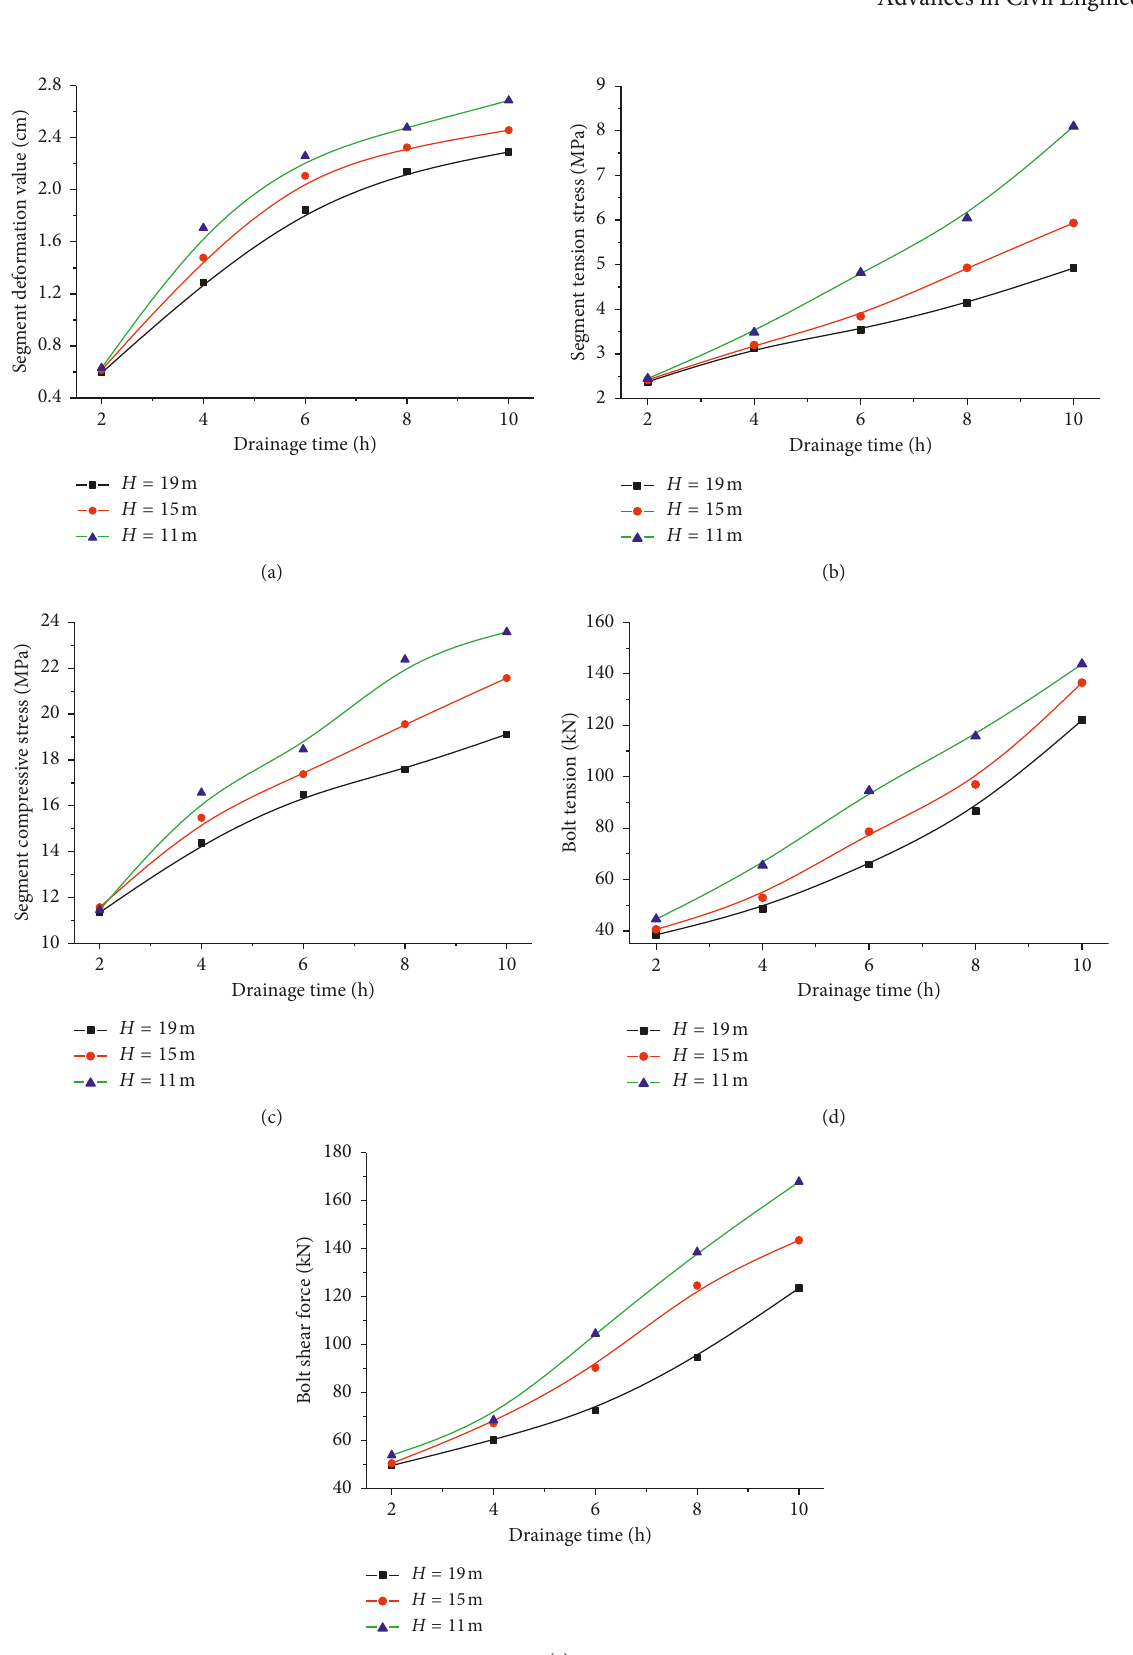
Figure 24: Internal force diagram of the segments and bolts corresponding to different reinforcement depths. (a) Maximum deformation value of the segment. (b) Maximum tensile stress of the segment. (c) Maximum compressive stress of the segment. (d) Maximum tensile force of bolts. (e) Maximum shear force of